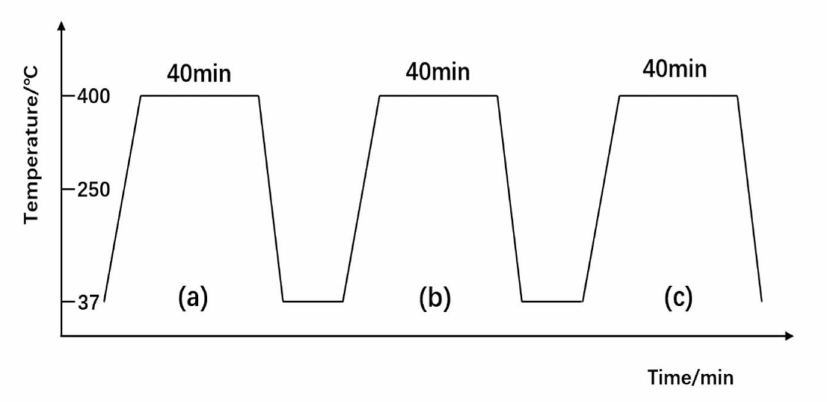
Figure 10. Schematic diagram of test process. ( a ) The first experiment; ( b ) The second experiment; ( c ) The third experiment.